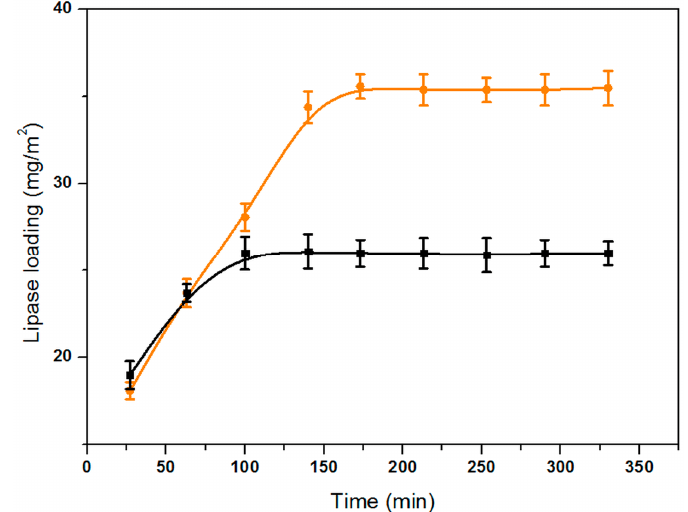
Figure 5. Effect of time on the enzyme loading of lipase on pristine ( ■ , black color) and PBAP-modified ( ● , orange color) PPMM.